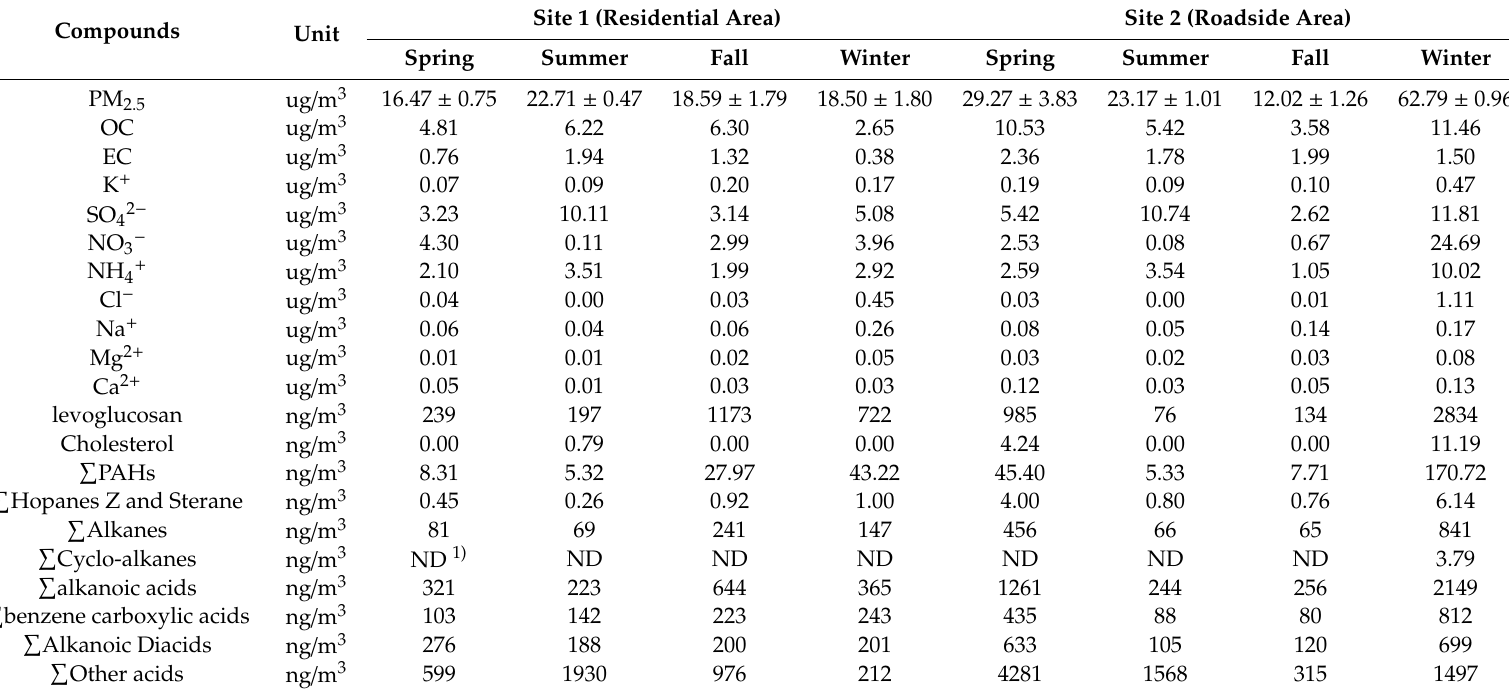
Table 4. Ambient concentrations of major chemical components of PM 2.5 measured at the residential area and roadside